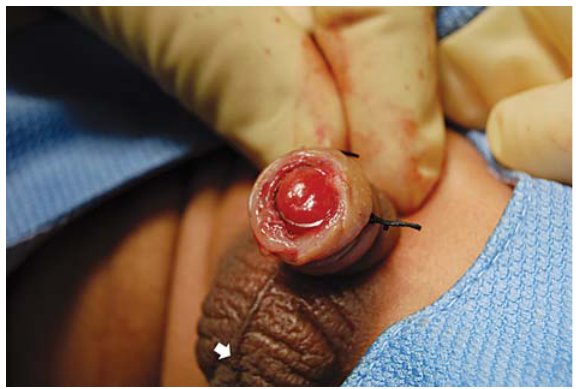
Figure 3 – Ligature placement when an appropriate amount of foreskin is drawn over the Plastibell.